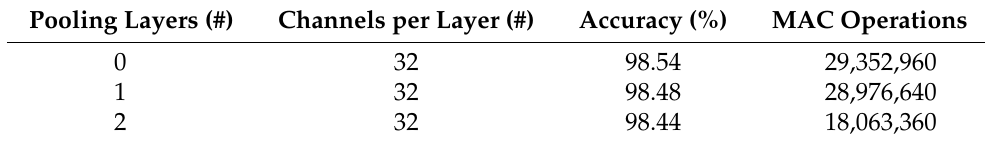
Table 1. Effect of adding pooling layers.